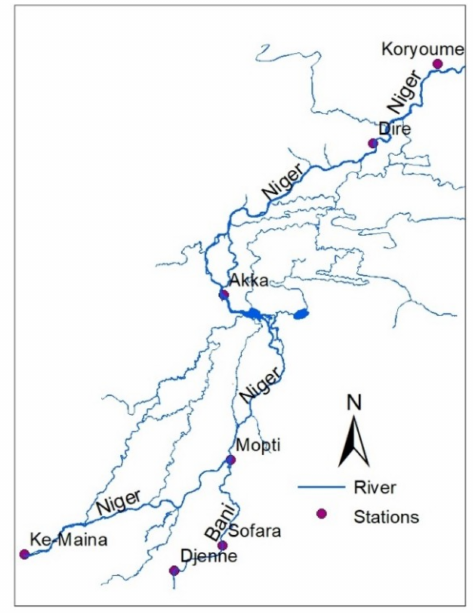
Figure 5. River network for the